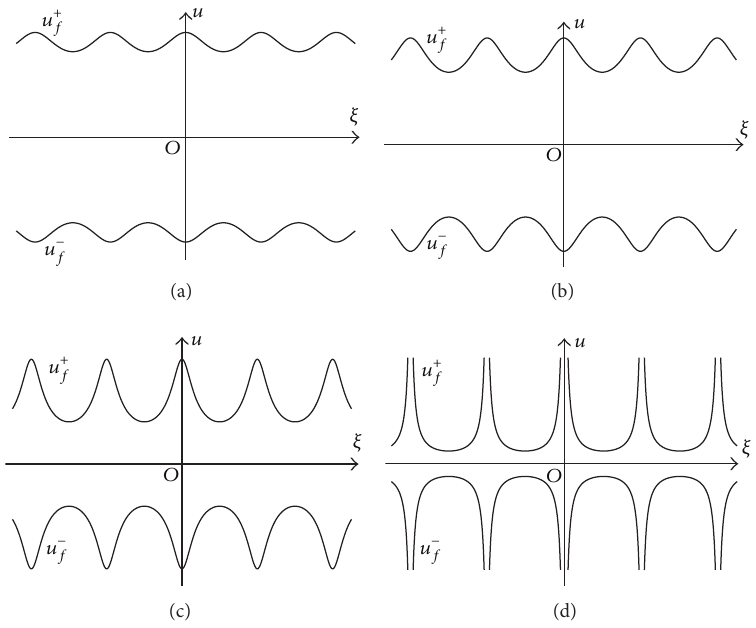
Figure 9: The periodic-blow-up waves are bifurcated from the symmetric periodic waves. The varying process for the figures of 𝑢 ± 𝑓 when 𝑏 → 0 − 0 , where 𝑐 = 𝑎 = 1 , 𝛾 = 𝛿 = −1 , and (a) 𝑏 = 0 − 10 −1 , (b) 𝑏 = 0 − 10 −2 , (c) 𝑏 = 0 − 10 −4 , and (d) 𝑏 = 0 − 10 −7 . (𝑎,𝑏) ∈ 𝐴 2 and